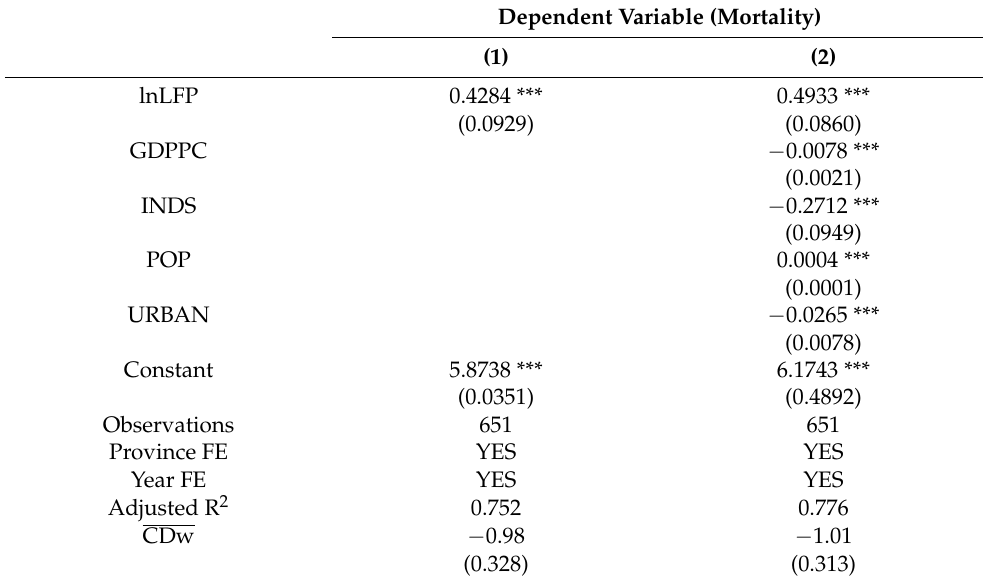
Table 2. Basic results of the impact of local fiscal pressure on public health in